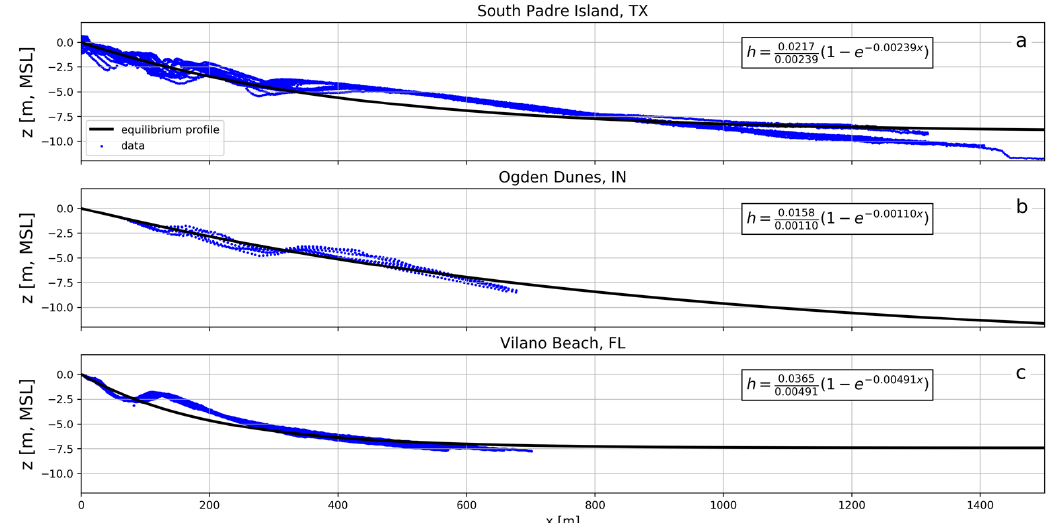
Figure 2. Nearshore bathymetry data (blue markers) and fitted equilibrium profile (solid black line) for the study sites. ( a ) Data and equilibrium profile for South Padre Island; ( b ) Ogden Dunes; and ( c ) Vilano Beach.